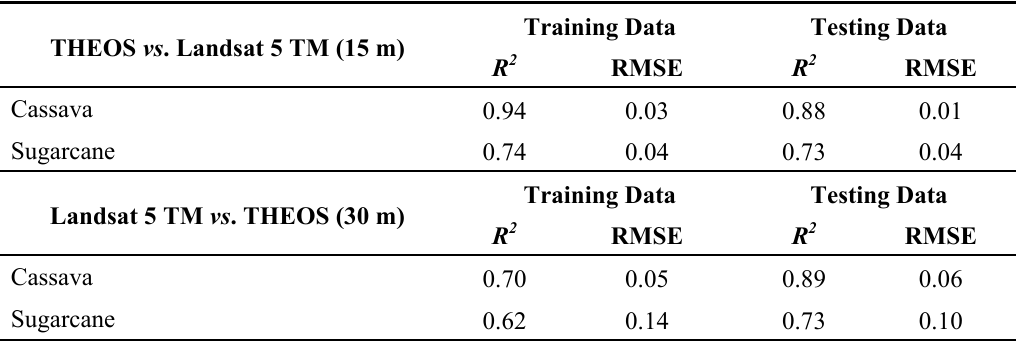
Table 7. Statistics linear regressions between THEOS and Landsat 5 TM at 15 and 30 m resolution for NDVI for cassava and